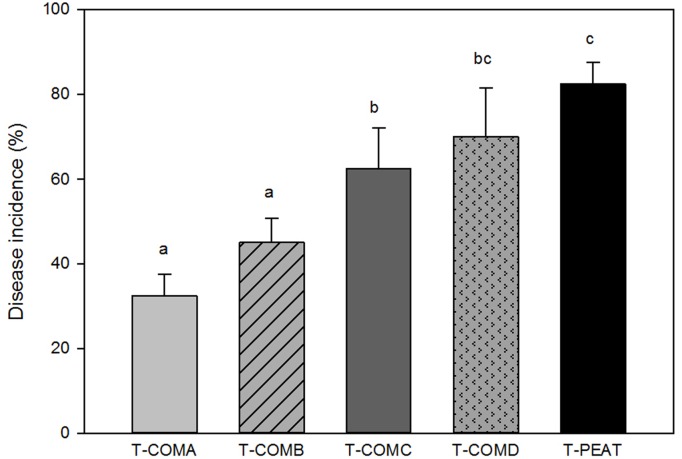
Disease incidence in pepper seedlings artificially inoculated with P. nicotianae.